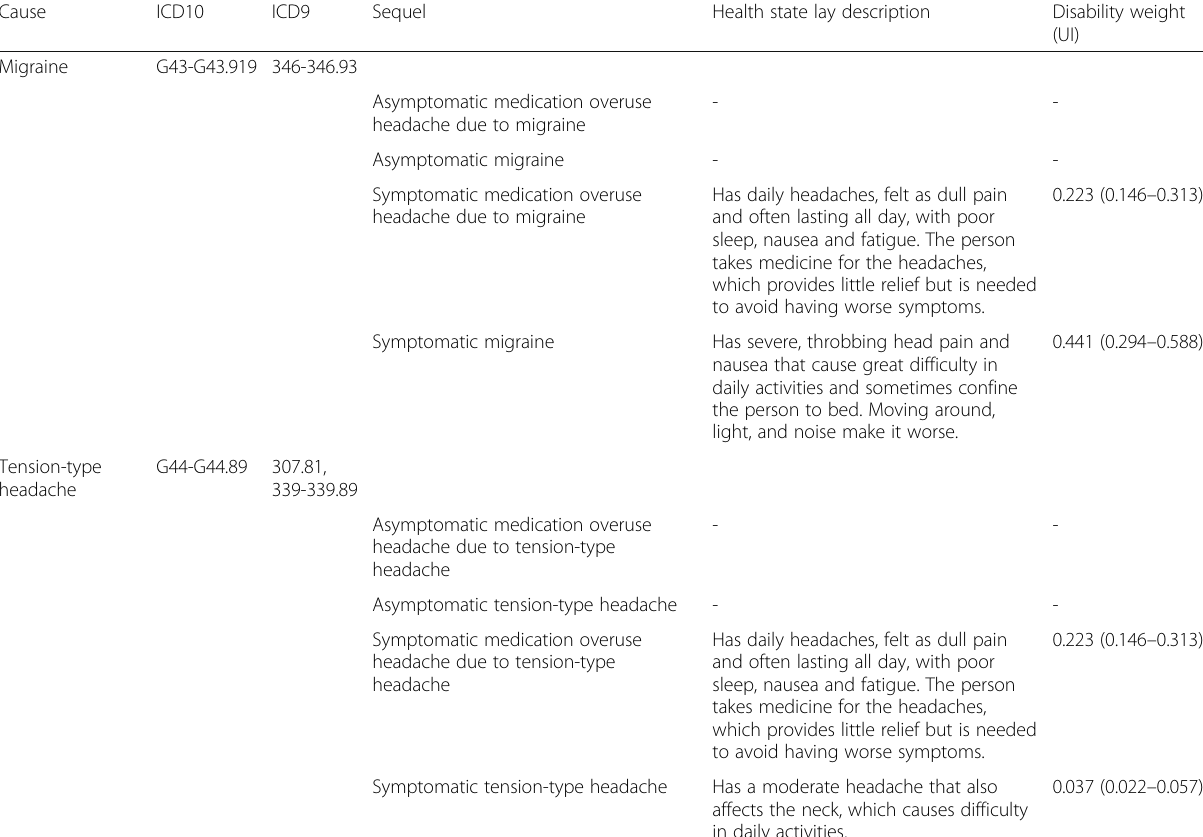
Table 1 ICD 10 codes, ICD 9 codes, sequelae, description, and disability weight of migraine and